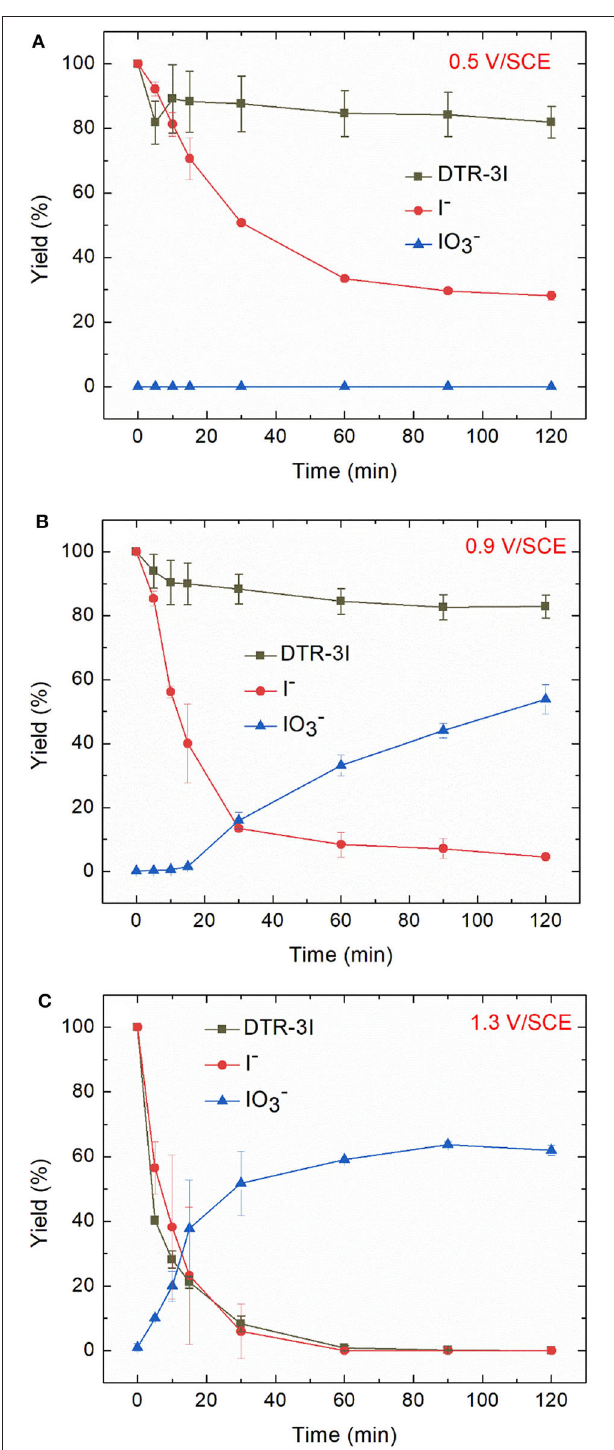
FIGURE 8 | Electrochemical oxidation of electroreduced diazoate solution (100mg L − 1 in 0.1mol L − 1 Na 2 SO 4 at − 1.3 V/SCE for 2h) at (A) 0.5 (B) 0.9V, and (C) 1.3 V/SCE. Error bars are based on duplicate